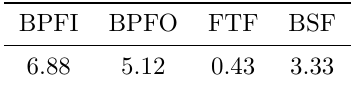
Table 2: Characteristic bearing fault frequencies in shaft